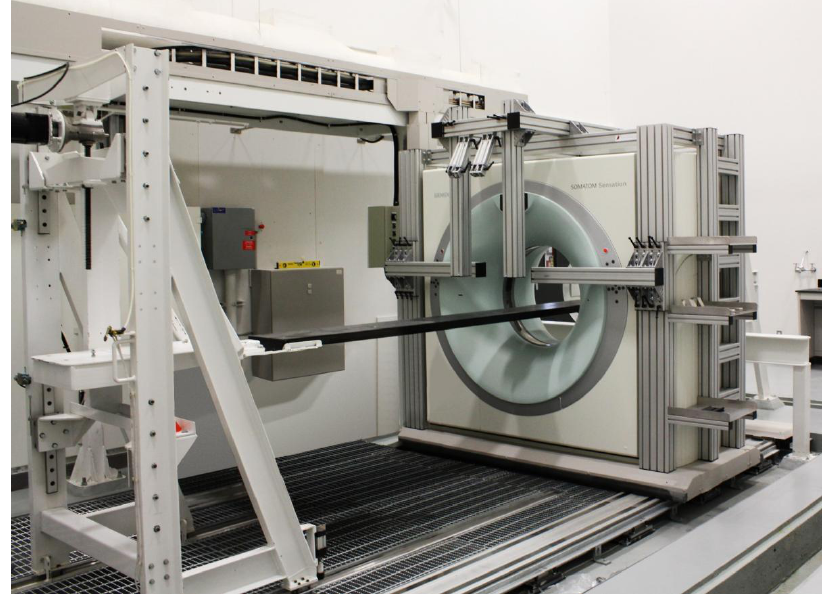
Figure 1. Siemens Somatom Sensation 64 designed for the human body but adapted for material research. Courtesy of INRS-ETE, Quebec, QC, Canada.